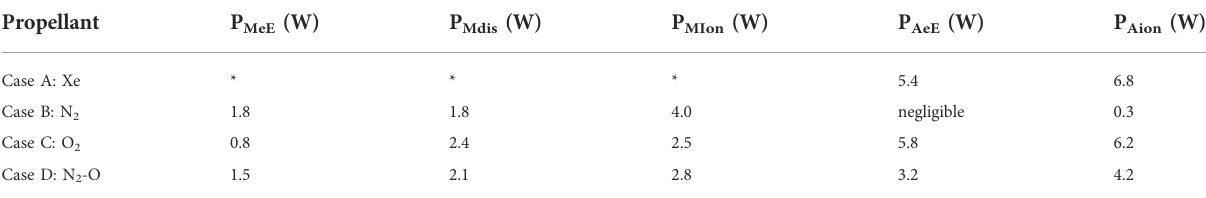
TABLE7Electronpowerloss(W)repartitioninthemaincollisionalmolecular(MeE-electronicexcitation,Mdis-dissociation,andMion-ionization)and atomic (AeE-electronic excitation and Aion-ionization) channels for the different